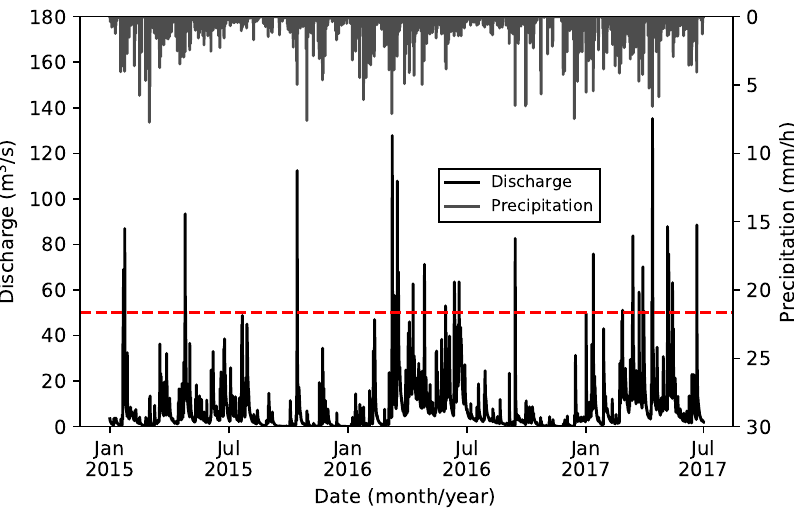
Figure 2. Precipitation (averaged for Toreadora, Virgen and Chirimachay stations) and discharge hourly time series for the study period (January 2015 to July 2017). Note the horizontal red dashed line at a discharge of 50 m 3 /s (historical indicator of a flood